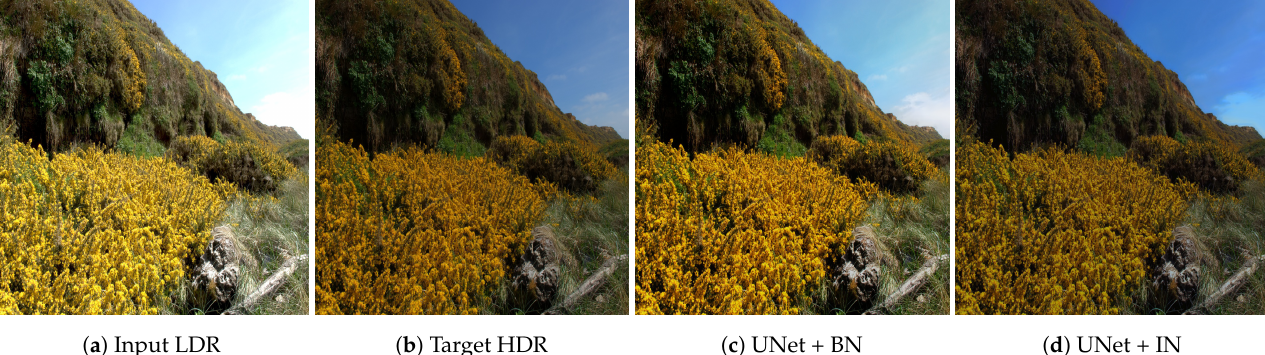
Figure 9. Training set samples for the GUNet and Autoencoder ablation studies. First column is the input LDR, followed by the target, prediction, mask, masked-target and masked prediction. Targets and predictions are tone-mapped. The masks show the fully over/under exposed regions.